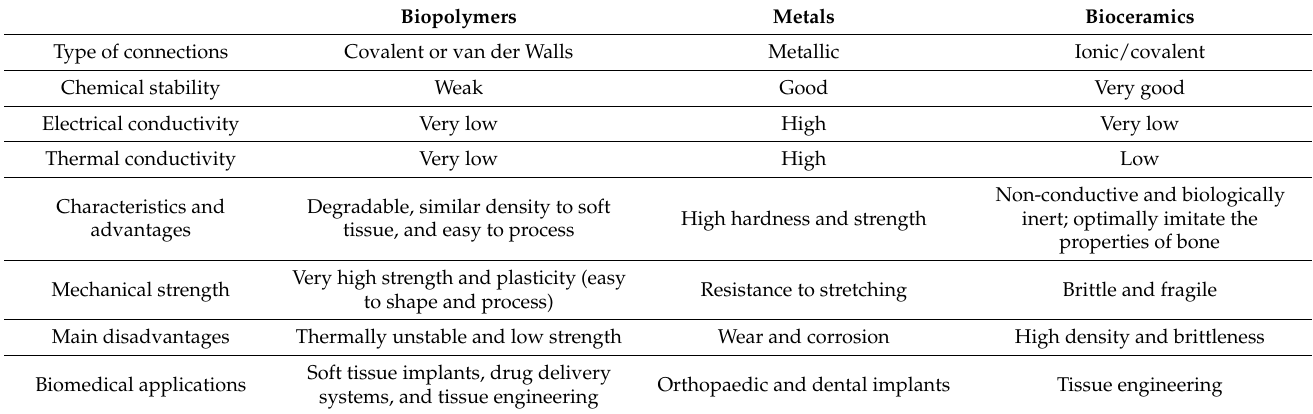
Table 1. General characteristics of different classes of